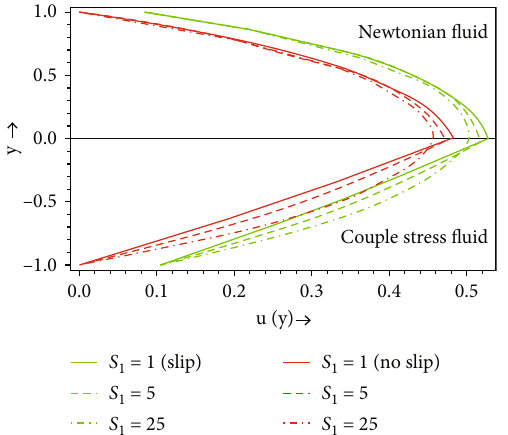
Figure 11: Velocity variation of couple stress and Newtonian fl uid with couple stress fl uid parameter s 1 .